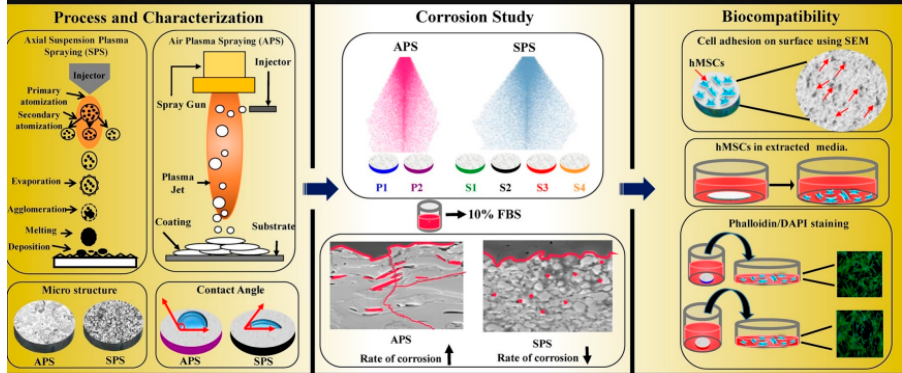
Figure 15. A schematic of SPS and APS methods, leading to different microstructures and wettability; corrosion studies in 10% fetal bovine serum (FBS) with 0.1% sodium azide, and in vitro biocompatibility experiments by hMSCs [160] (reproduced with permission number: 5071090717980, Elsevier).